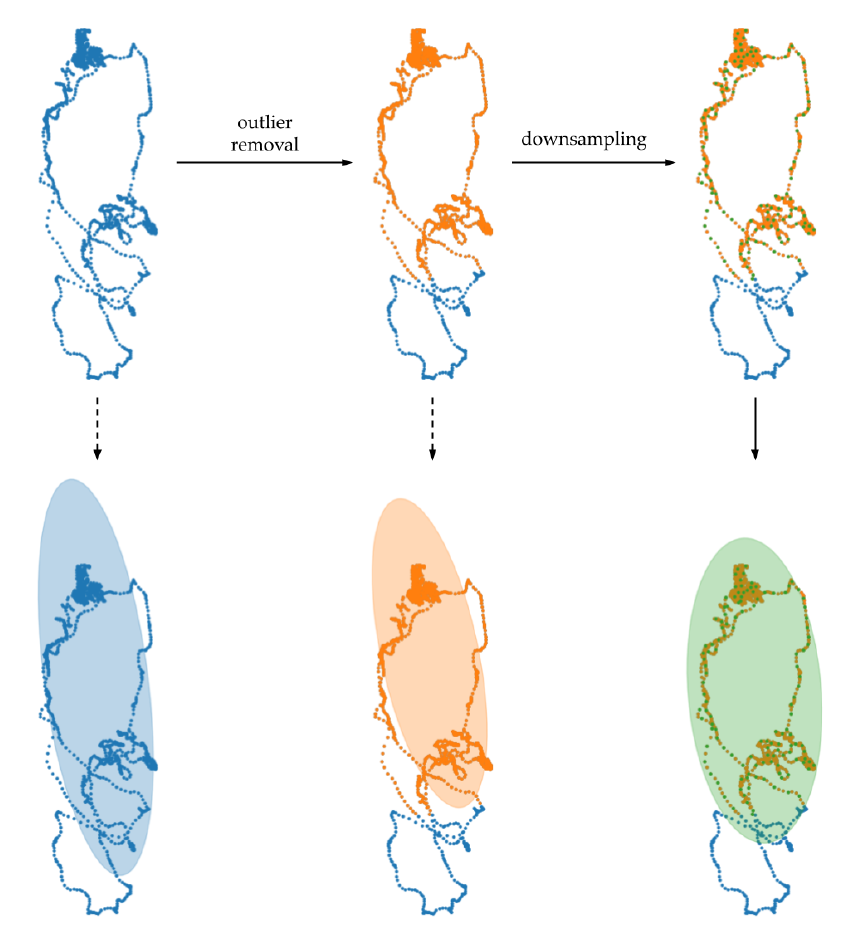
Figure 3. Effect of individual trajectory processing steps on the resulting shape of the ellipse. Omitting pre-processing leads to the inclusion of an area not covered by the trajectory in the ellipse. The removal of outliers reduces the effect of single parts of trajectories deviating from the general course of motion, but the result is still affected by areas of density resulting from the low amplitude of motion. Downsampling in the form of removing adjacent points reduces the excess area of the ellipse and leads to changes in its orientation due to the areas of